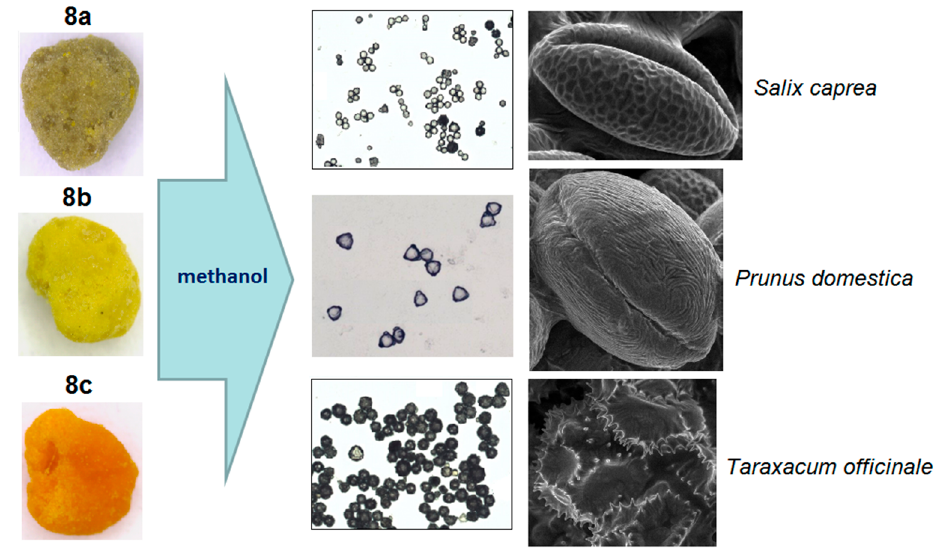
Figure 9. Microscopic identification of pollen grains in methanol extracts from green, yellow and orange loads ( 8a – c ) of BP8 .